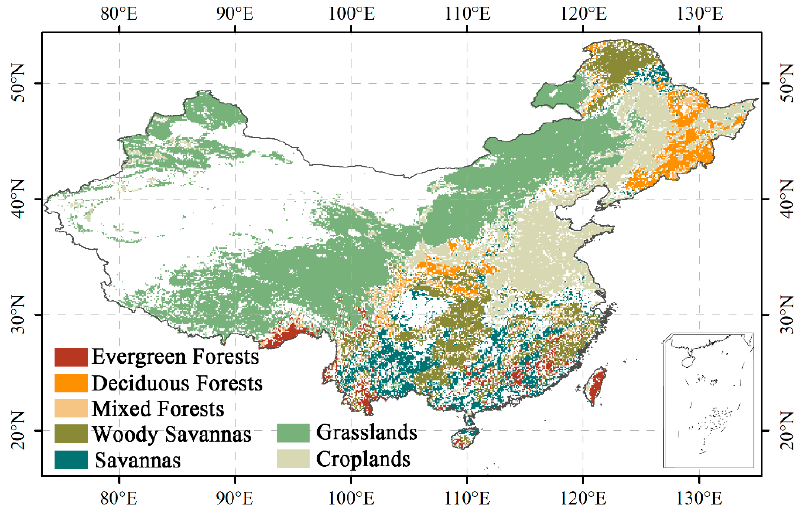
Figure 1. Spatial distribution of vegetation types in the selected study area across China (the white area represents the pixels that were excluded for further analysis, including land cover type that has changed from 2001 to 2020, non-vegetation cover, and shrublands cover).